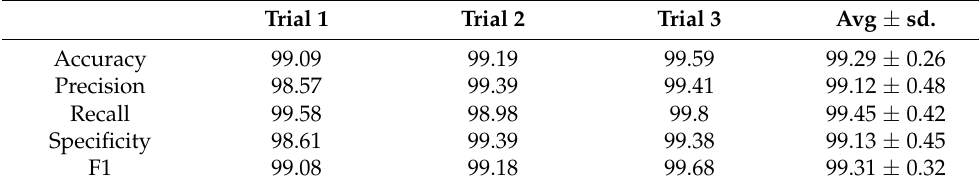
Table 3. Classification results (expressed as a percent) obtained on the CT dataset with a split of 60:40.